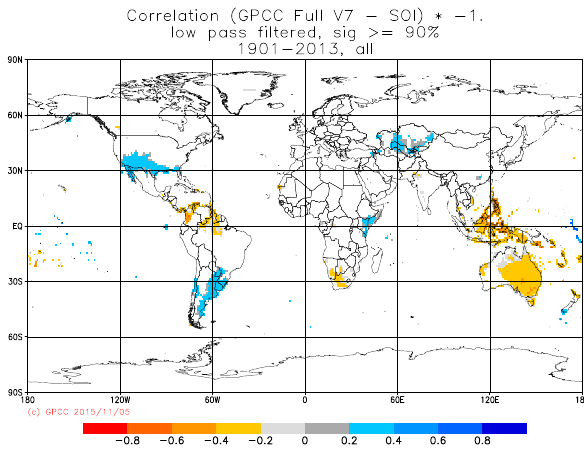
Figure 1. Station data coverage of GPCC’s near real-time “Moni- toring Product” and “First Guess Product” (indicated by “FG”), as well as for the five most recent Versions of the centennial “Full Data Reanalysis with the most recent Version 7” from June 2015.